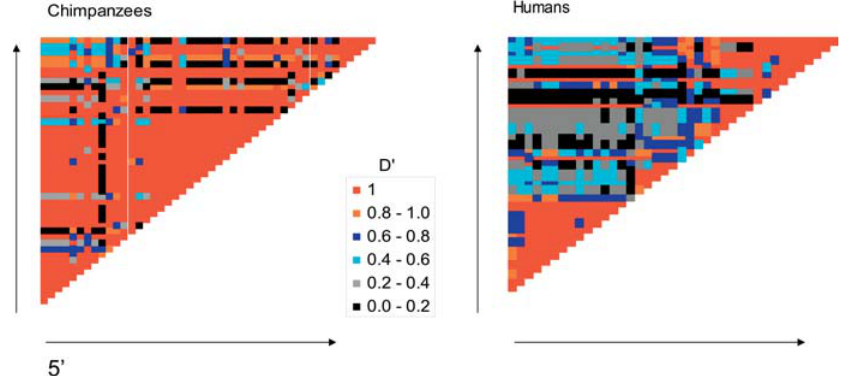
Figure 1. Patterns of Pairwise LD in Humans and Chimpanzees Only SNPs with minor allele frequencies above 0.1 are included. The rows corre- spond to the consecutive SNPs in the region, as do the columns. Each cell indicates the extent of LD between a pair of sites, as measured by j D 9 j (estimated using the Expectation Maximization al- gorithm, as implemented by Arlequin: http://lgb.unige.ch/arlequin/). DOI: 10.1371/journal.pbio.0020155.g001